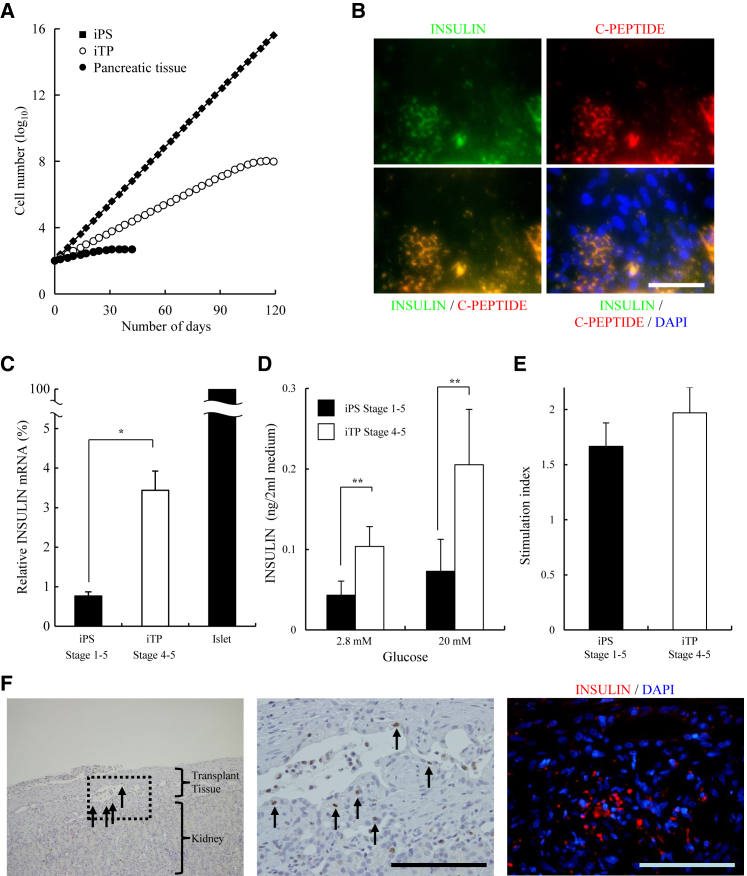
Proliferation of iTP Cells and Their Differentiation into Insulin-Producing Cells(A) Growth curves of iPSCs, iTP cells, and pancreatic tissue cells. (B) Immunohistochemical analysis of INS-producing cells (INS, C-PEPTIDE) derived from iTP05 cells treated with the stepwise protocol. Scale bar, 100 μm. (C) qRT-PCR analysis of INS expression in differentiated iTP05 cells. qRT-PCR analysis of differentiated cells derived from iTP05 cells (passage 10) at stages 4–5, derived from iPSCs at stages 1–5. Isolated islets (islets >80%) were used as a positive control. The data are expressed as the INS:GAPDH ratio, with that of the islets arbitrarily set to 100 (n = 4). Error bars represent the SE. (D) INS release assay. Differentiated cells derived from iTP05 cells (passage 10) using the stage 4–5 protocol and derived from iPSCs using the stage 1–5 protocol were treated with 2.8 and 20 mM D-glucose, and the amount of INS released into the culture supernatant was analyzed using an ELISA. Error bars represent the SE. (E) The stimulation index shown in (D). Error bars represent the SE. *p < 0.05. (F) Immunohistochemical analysis of Ki67 expression (left panel, low magnification; middle panel, high magnification [dotted square, left panel] and INS expression (right panel, red cells) derived from engrafted iTP05 cells in the graft. Scale bars, 100 μm.